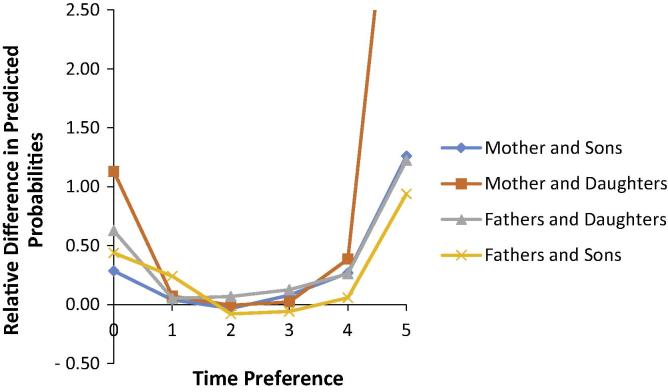
Relative difference in predicted probabilities of parents and offspring having same and conflicting time preference categories. Notes: On the x-axis, 0 = next week, 1 = next few months, 2 = next year, 3 = next 2–4 years, 4 = next 5–10 years, and 5 = 10+ years. The conflicting time preference category combinations are: offspring planning next week and parent planning 10+ years, offspring planning next few months and parent planning next 5–10 years, offspring planning the next year and parent planning next 2–4 years, offspring planning next 2–4 years and parent planning next year, offspring planning next 5–10 years and parent planning next few months, and finally, offspring planning next 10+ years and parent planning next week.